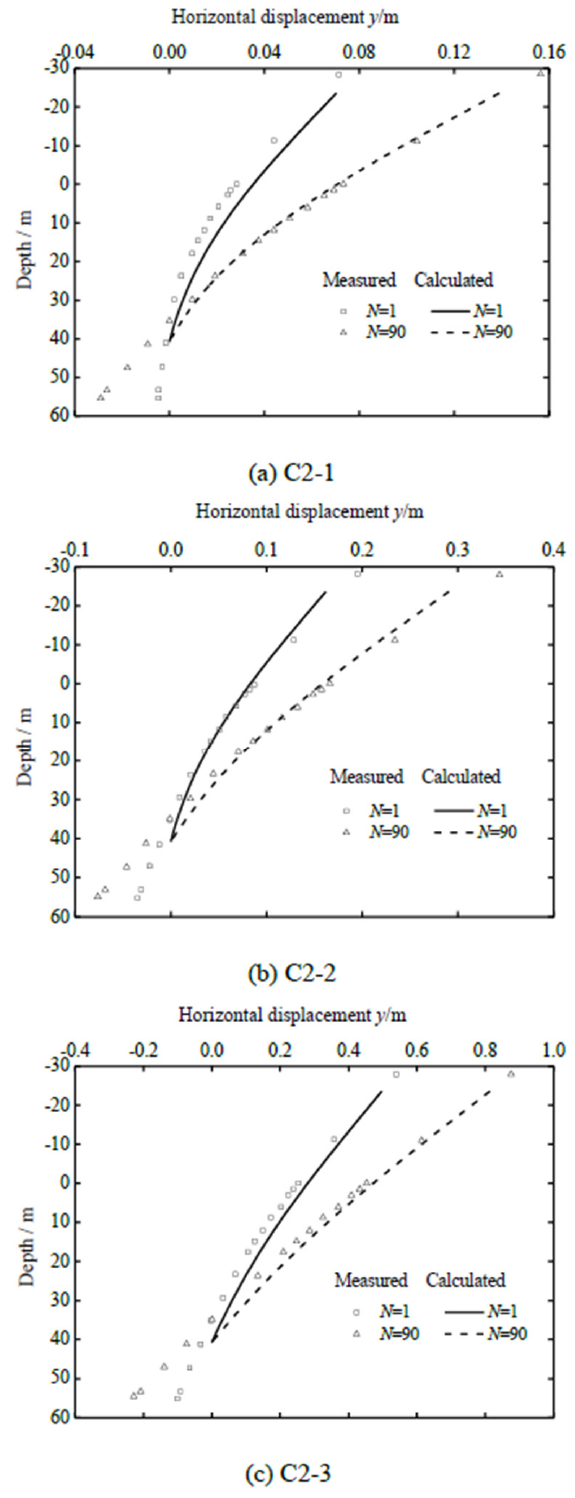
Figure 11. Comparisons of cyclic horizontal displacements.